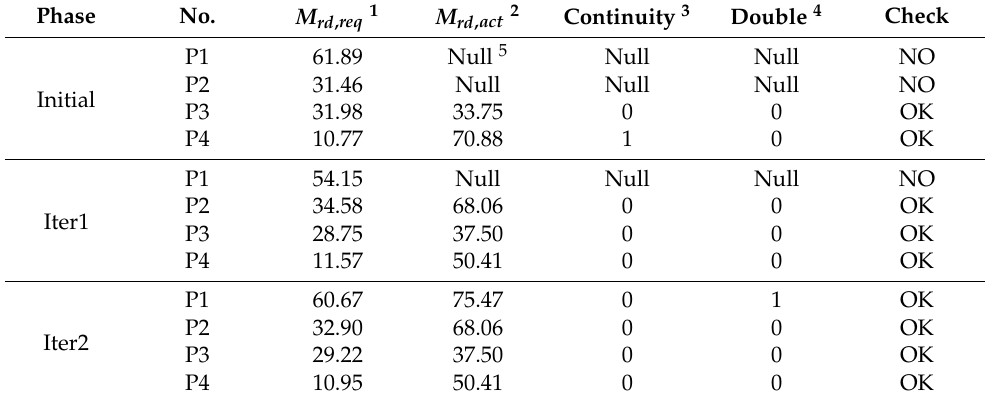
Table 5. Required web panel in each iteration.